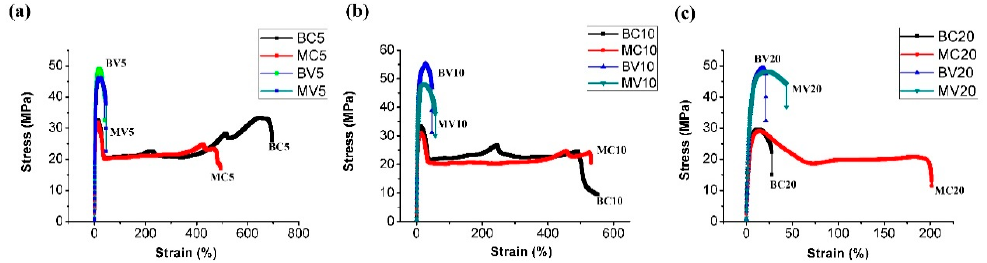
Figure 6. Selected stress–strain curves of various samples with different PET contents: ( a ) 5%, ( b ) 10% and ( c ) 20%.